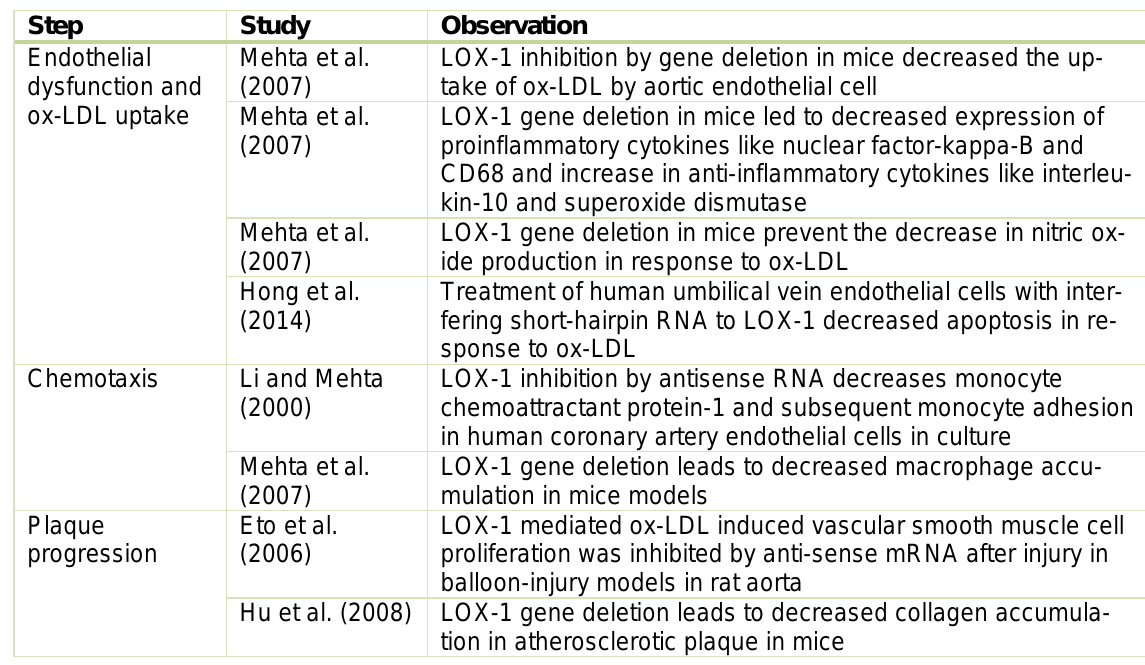
Table 1: Important observations about the impact of LOX-1 inhibition on different steps of atherosclerotic plaque